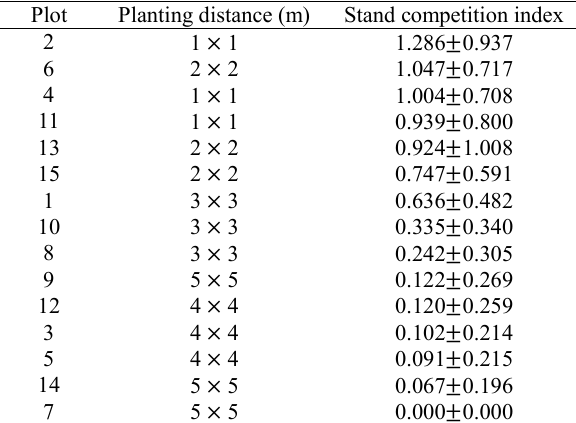
Table4. Stand competition in different planting distance Plot Planting distance (m)